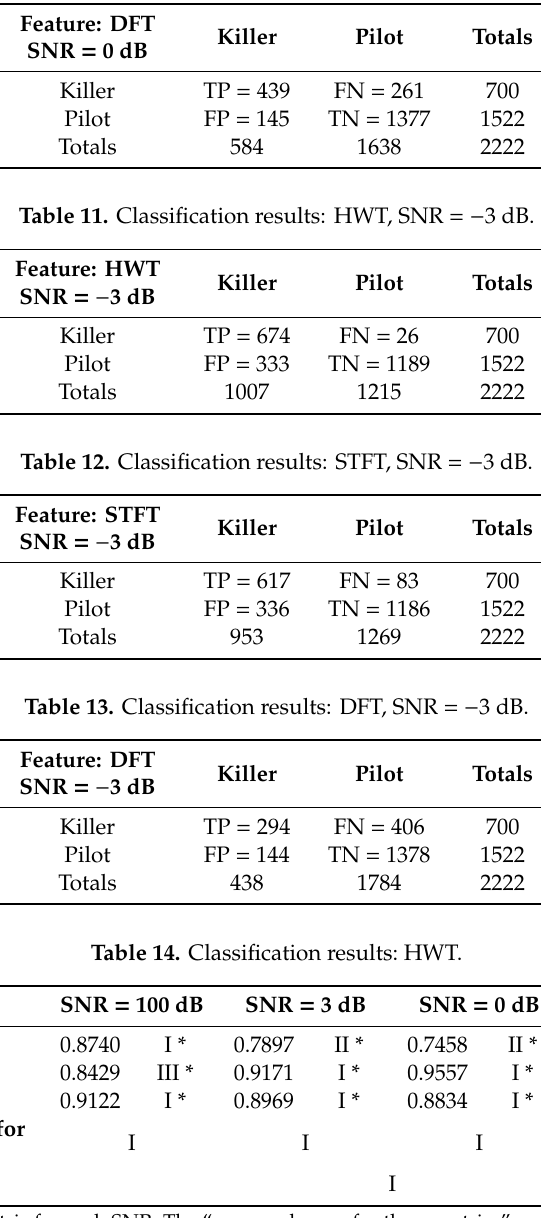
Table 10. Classification results: DFT, SNR = 0 dB.